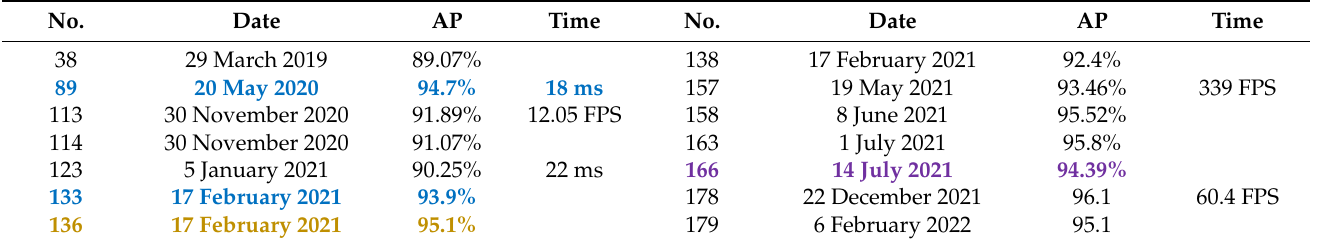
Table 7. The performance evolution of detectors on SAR-Ship-Dataset (the data come from the 177 papers).